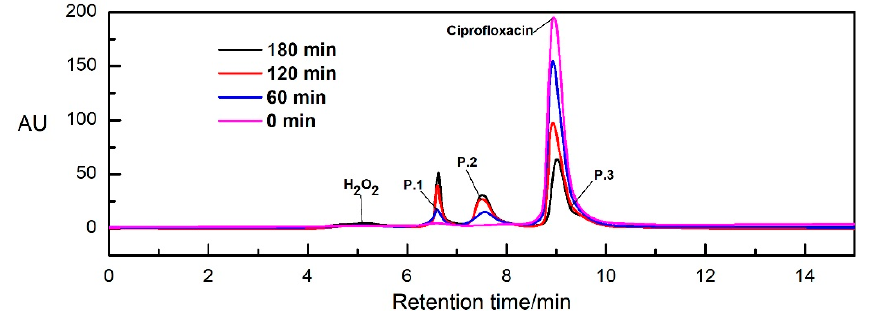
Figure 11. Changes in the HPLC spectra of degradation of ciprofloxacin by the US/E/PS system.